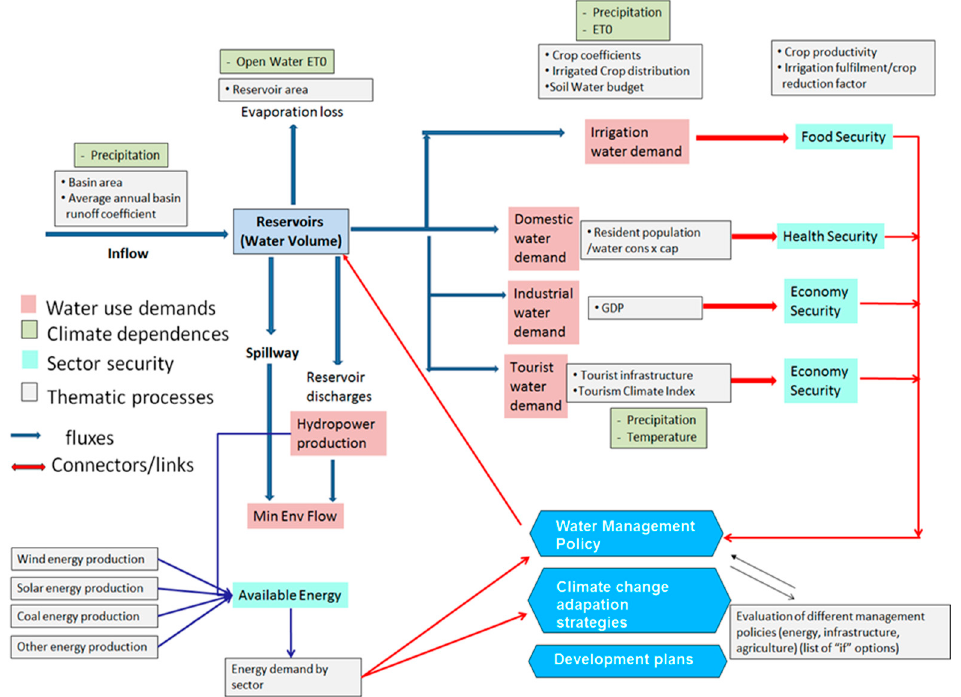
Figure 2. Conceptual diagram describing the major nexus components relevant for the Sardinia